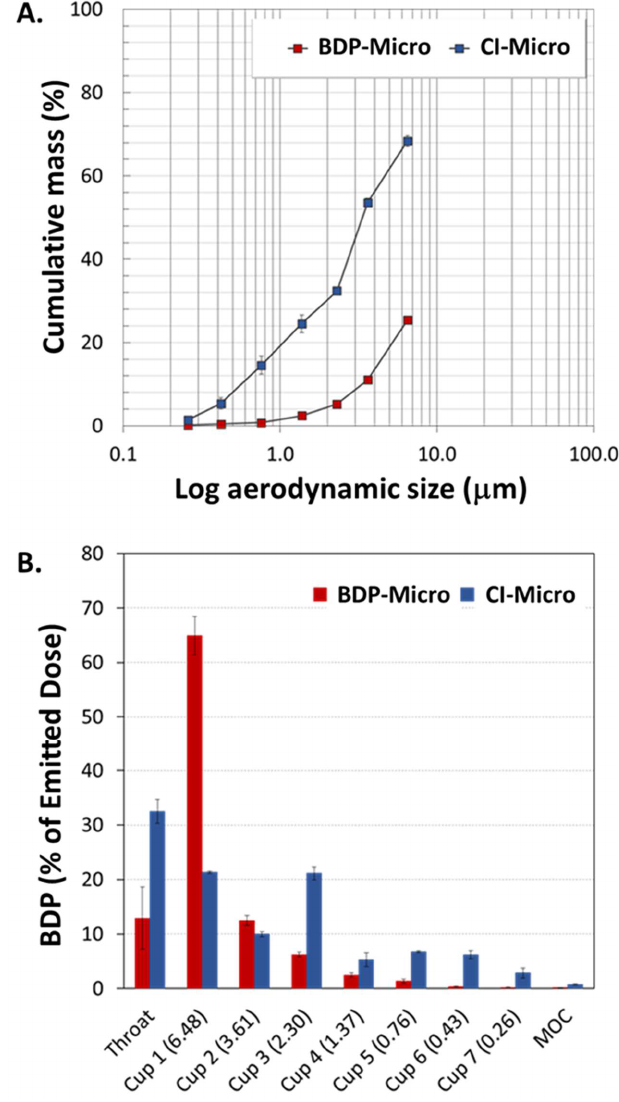
Figure 3. In vitro aerosol performance of BDP-Micro and CI-Micro upon delivery through Next Generation Impactor (NGI). ( A ) Cumulative mass recovered as a function of the cut-off diameter of the NGI; ( B ) NGI deposition pattern. The formulations were delivered at 90 L/min through the low-resistance DPI Breezhaler ® . Data are the mean ± SD of values calculated on three different